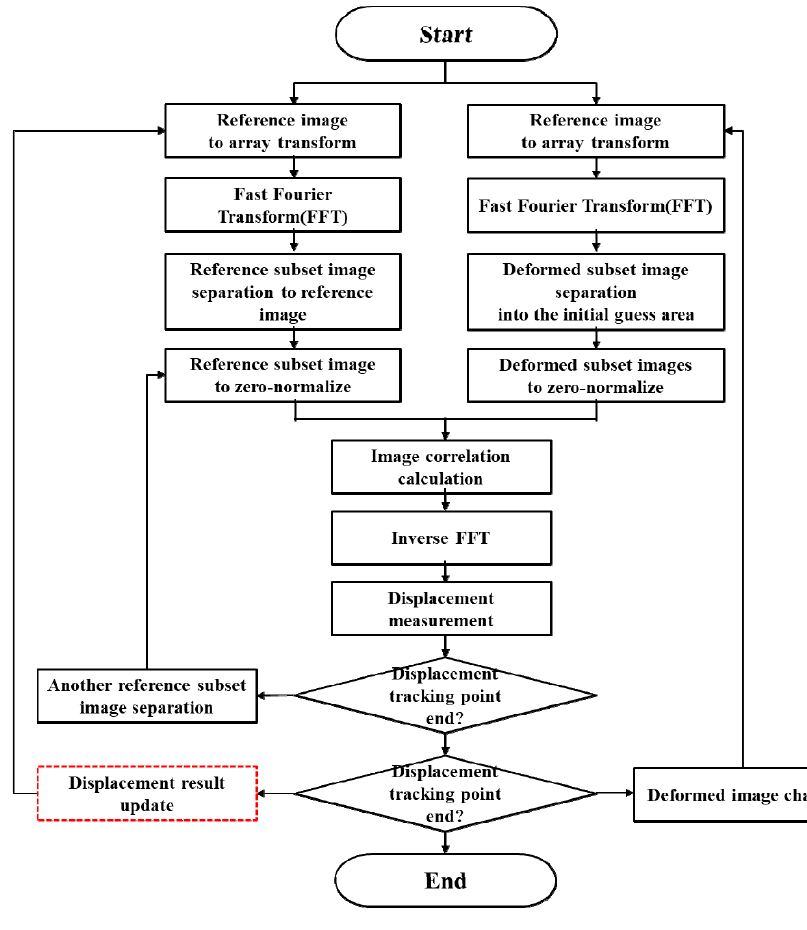
Figure 4. The optimization of the initial guess area size to reduce the calculation of the image correlation between the reference image and the deformed image for the auto captured images by using FFT, based on the digital image correlation measurement devices. (Red-dot box: added displacement feedback process).